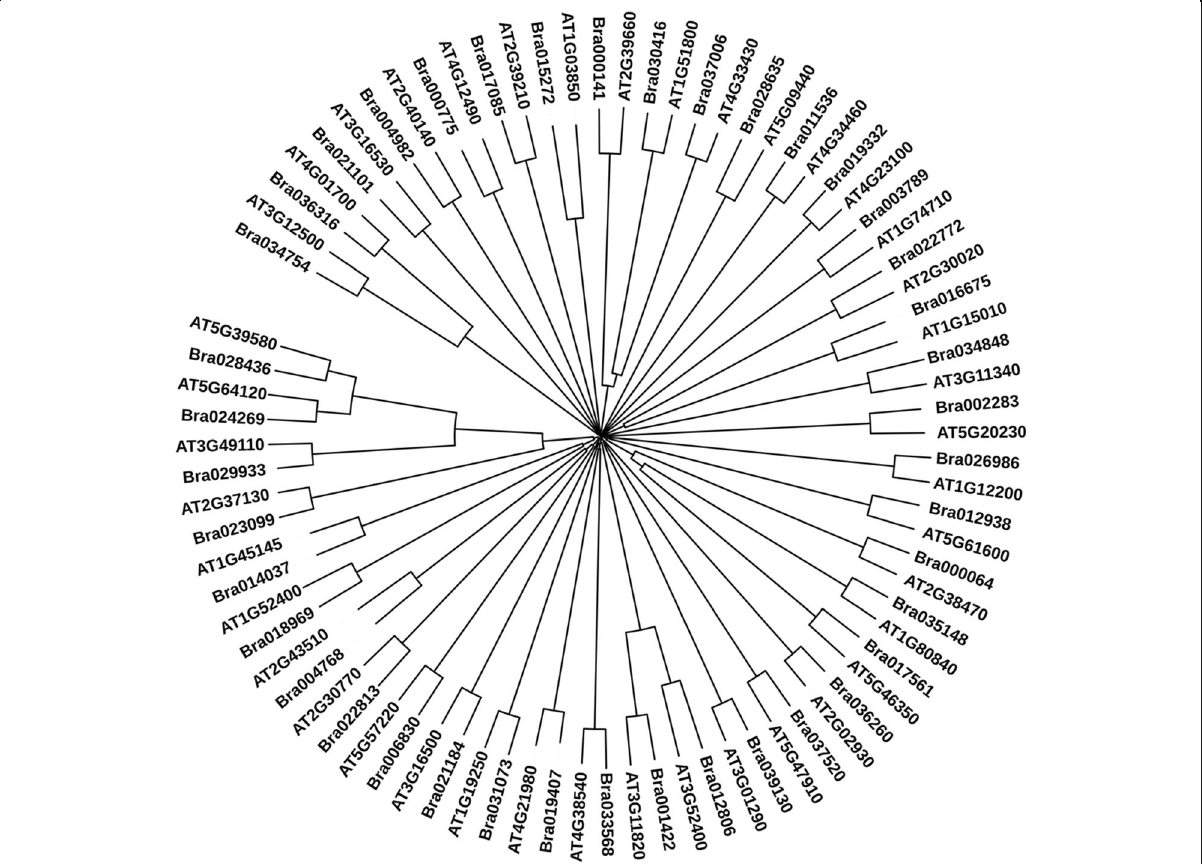
Fig. 3 Neighbor-Joining tree was constructed to determine the relationship among Arabidopsis and Brassica sequences involved in defense response against fungi extracted from contrast WTC and